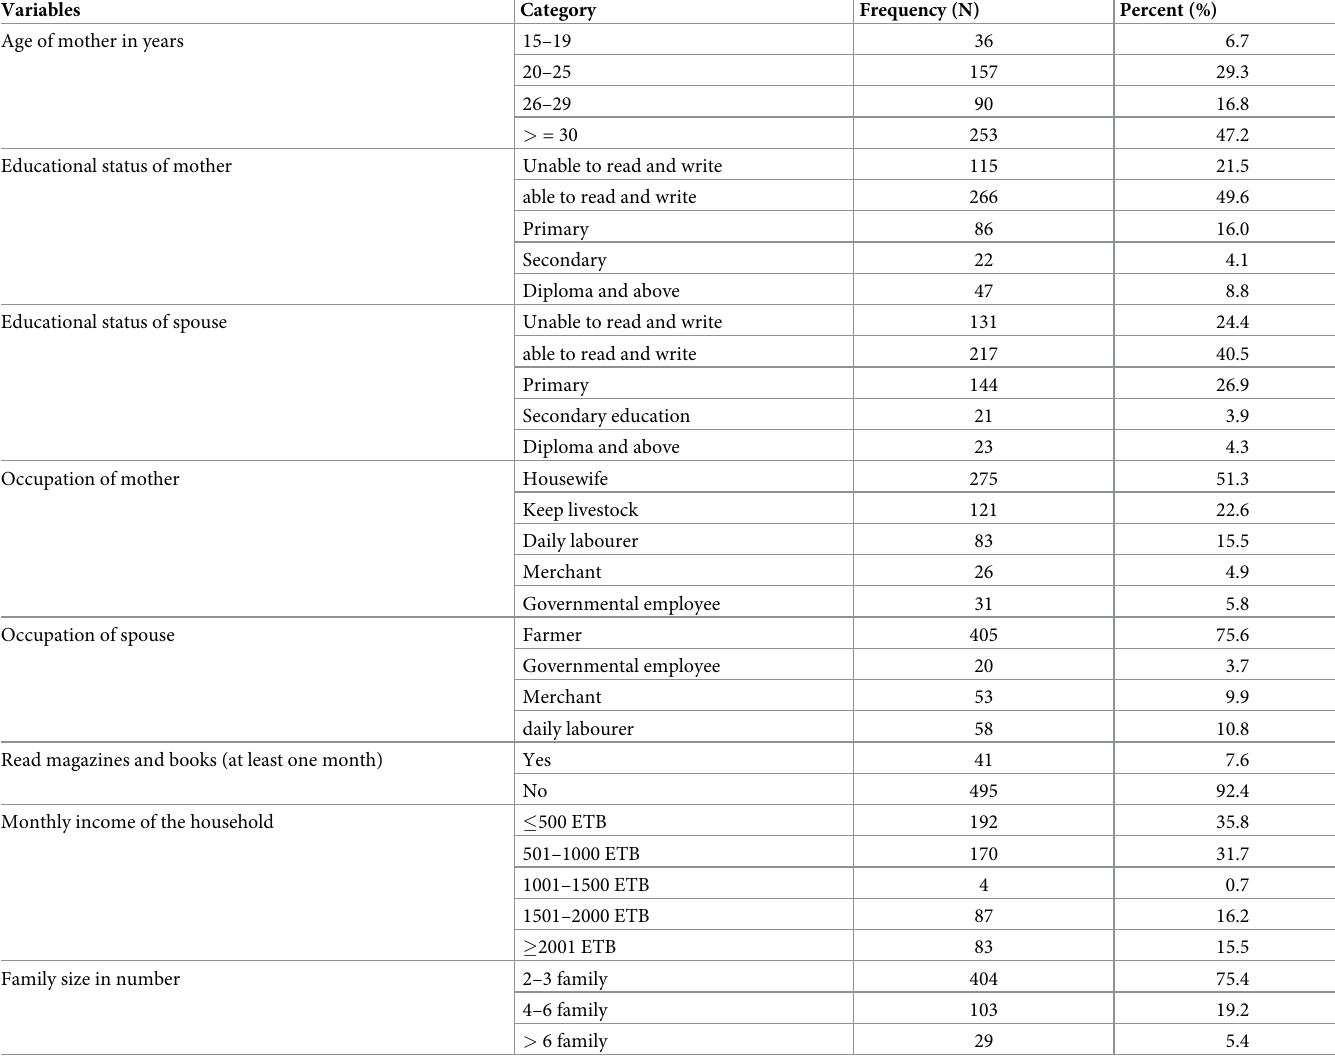
Table 1. Socio-demographic characteristics of mothers in Farta district (n = 536), Ethiopia,